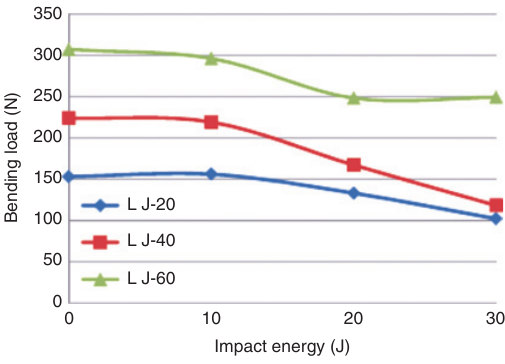
Figure 9 Variation of the bending loads according to impact energy in the composite lap